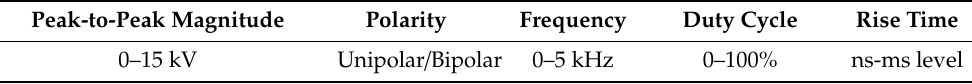
Figure 2. Testing platform for the growth of the electrical tree. ( a ) Schematic diagram and a ( b ) physical picture of square wave power supply. Table 1. Parameters of square wave voltage.